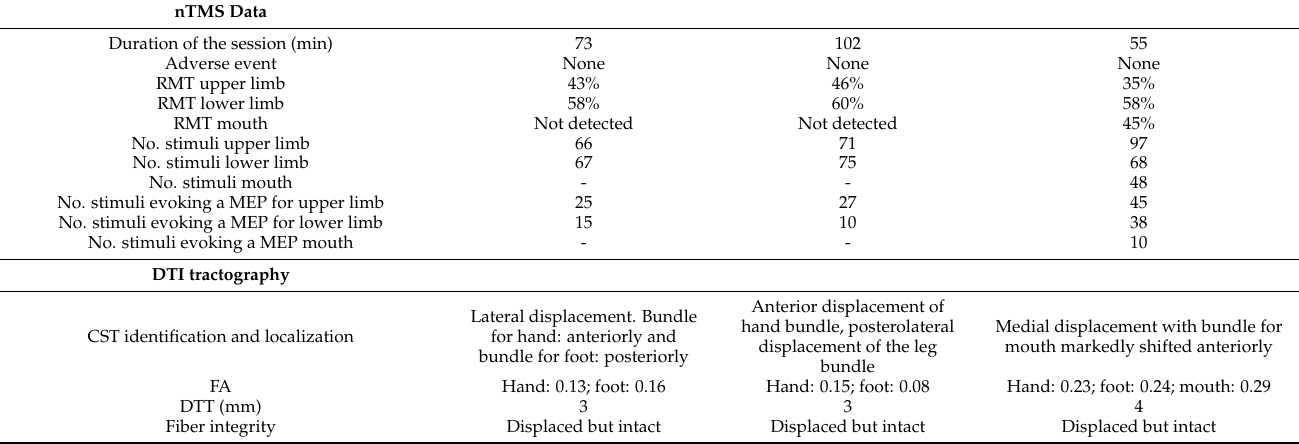
Table 2. nTMS and DTI tractography